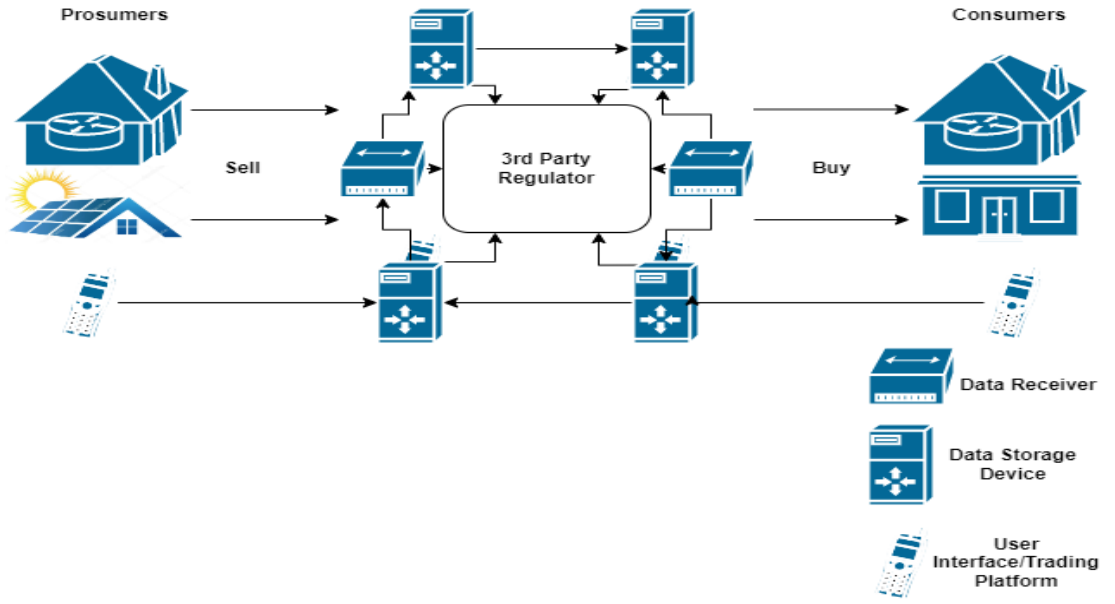
Figure 1. System architecture of the proposed system